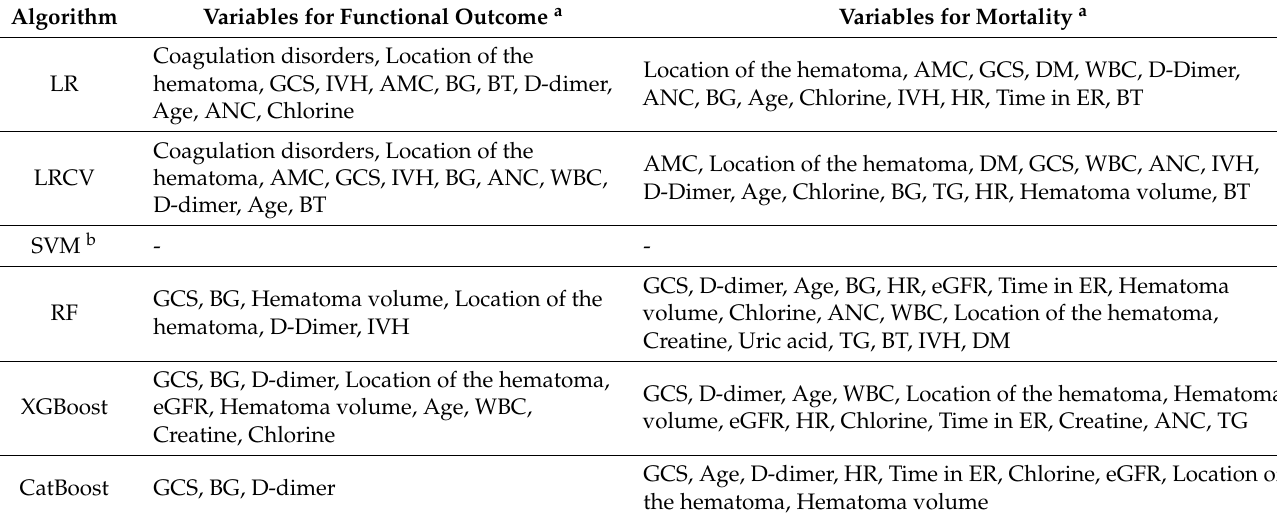
Figure 2. The receiver operating characteristic (ROC) curve of all the six machine learning (ML)-based models compared with the traditional ICH Score, with respect to predictive performance for the functional outcome at the third month. Table 3. List of variables used in the final